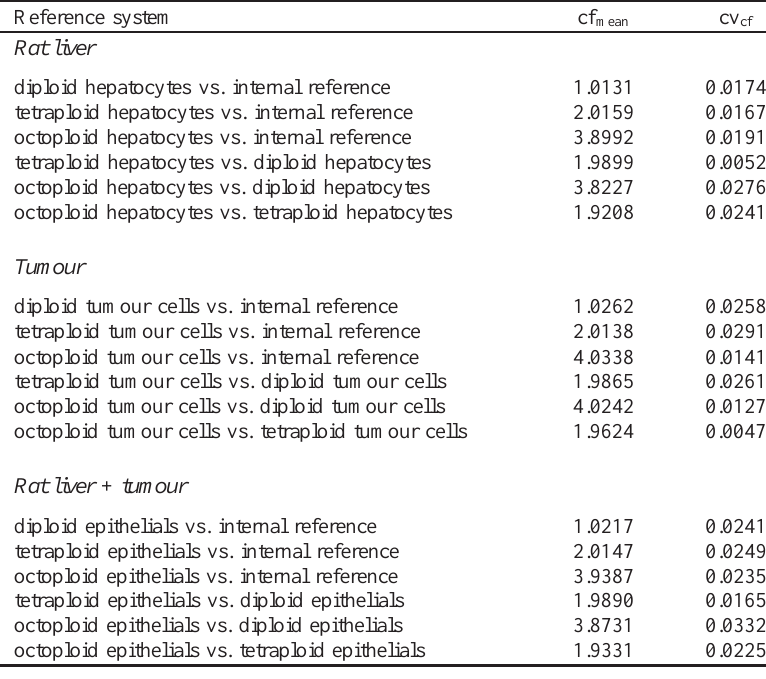
Table 2 Actual cf mean and cv cf for different reference/analysis cell combinations in 27 rat liver imprints and 53 diploid breast cancer FNAB with euploid stemlines. The results are separated for rat liver imprints, tumour specimens, and